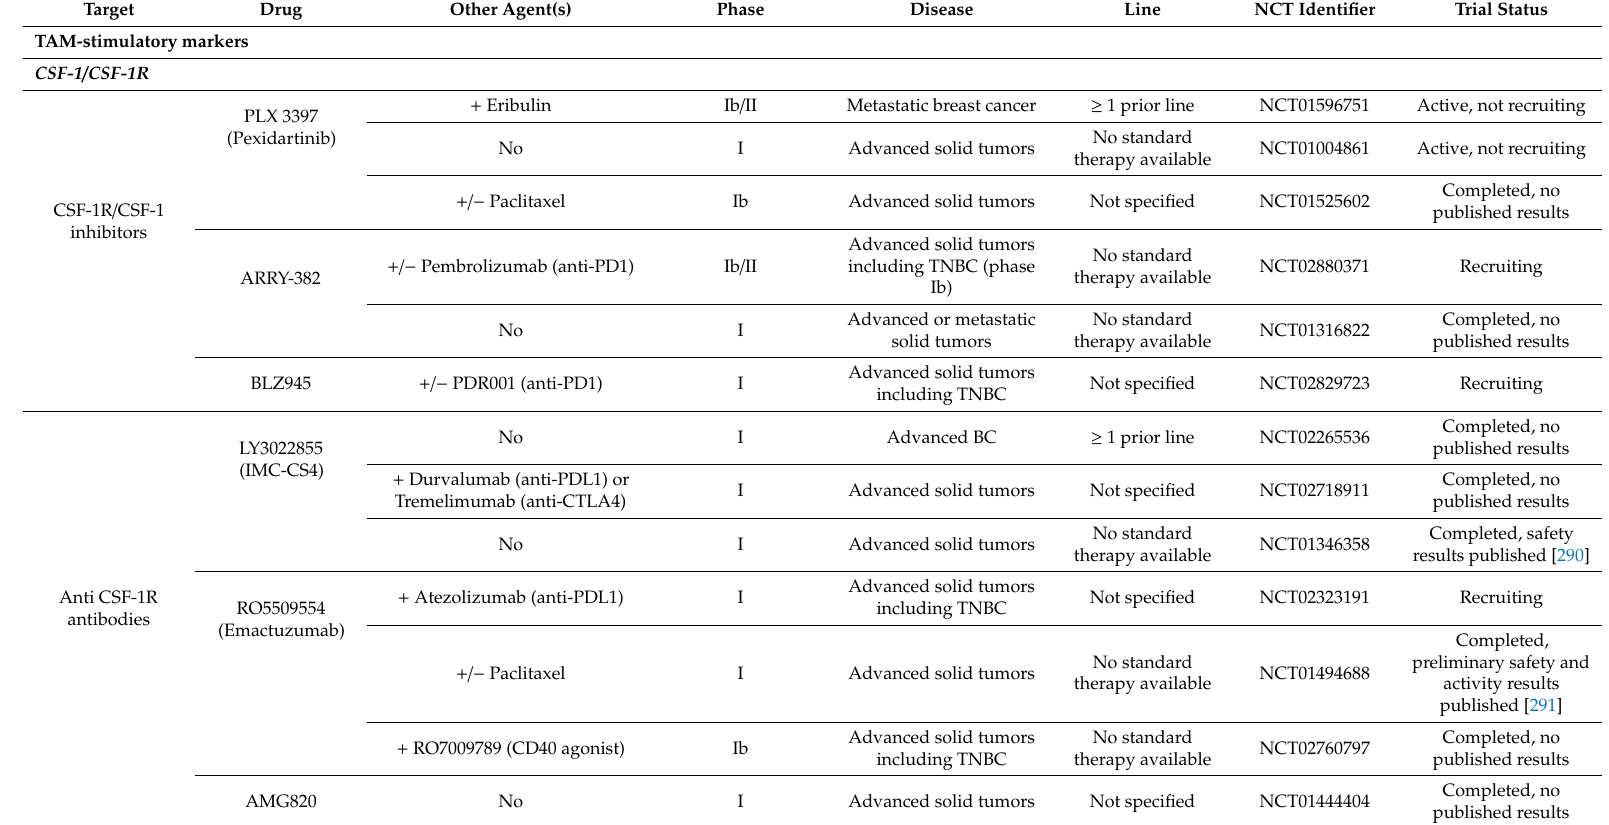
Table 4. Ongoing clinical trials potentially including breast cancer patients for targeting of immune-related markers predominantly expressed on macrophages, NK and dendritic